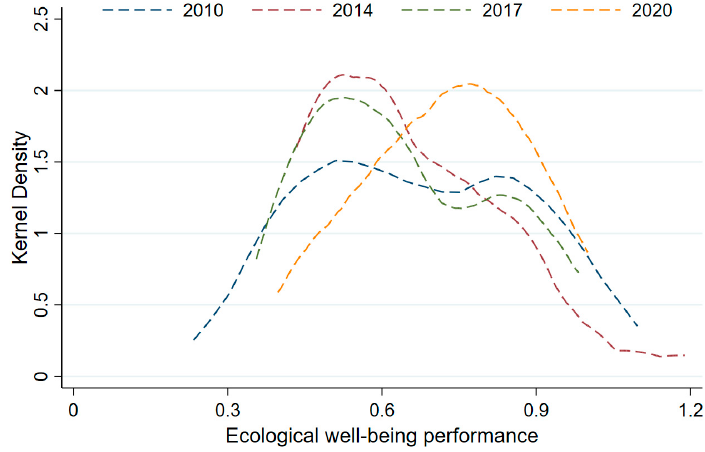
Figure 5. The kernel density of EWP in the TGRA, 2010–2020.